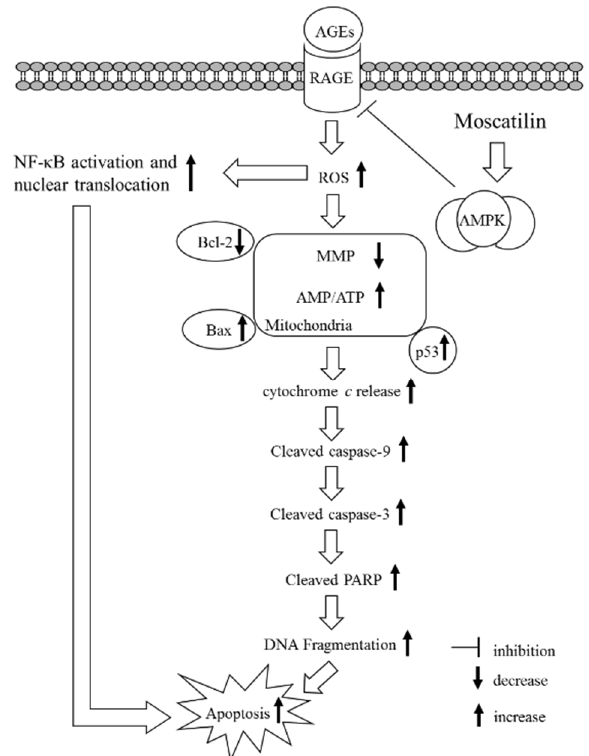
Figure 6. A summary diagram for the possible action of moscatilin on AGEs-treated SH-SY5Y cells. Moscatilin suppresses AGEs-induced RAGE expression by activating AMP-activated